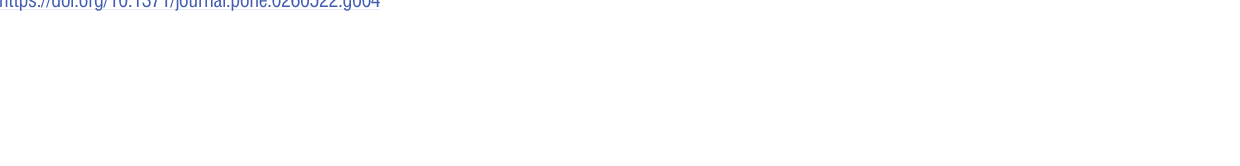
PLOS ONE | https://doi.org/10.1371/journal.pone.0260522 December2,